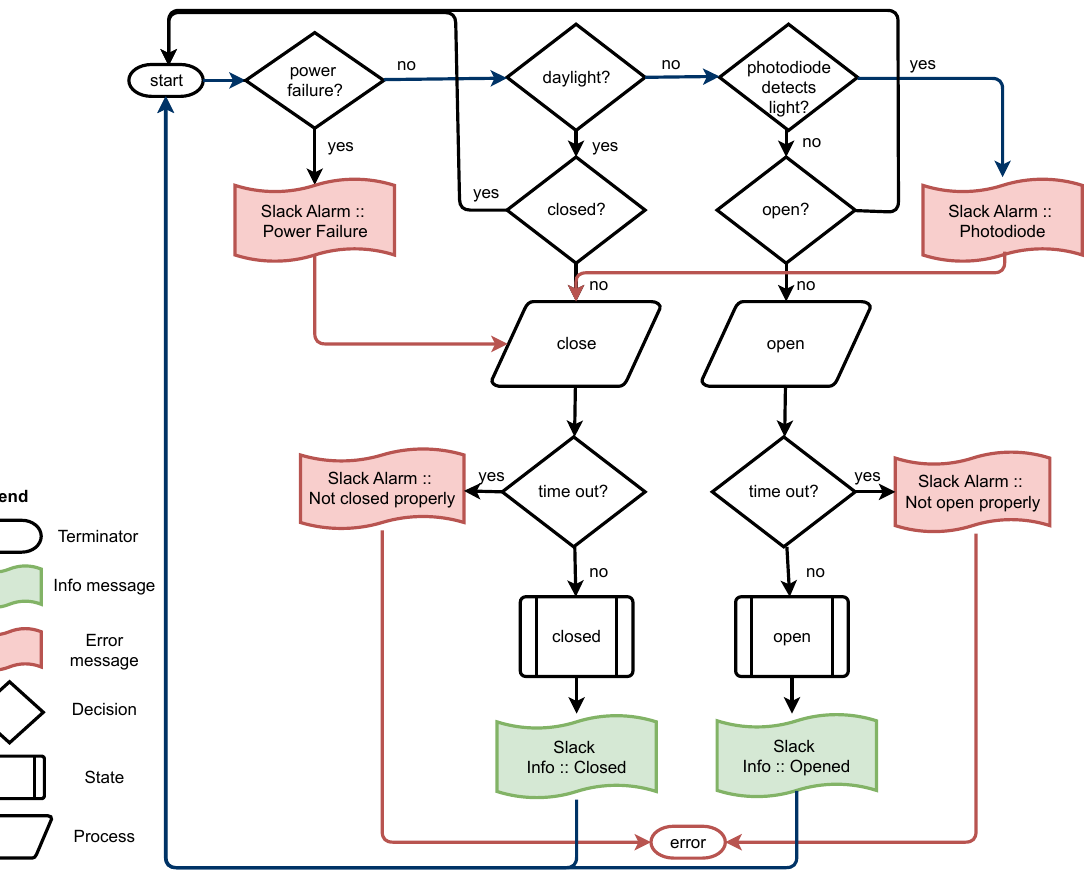
Figure 3. Flowchart of cover